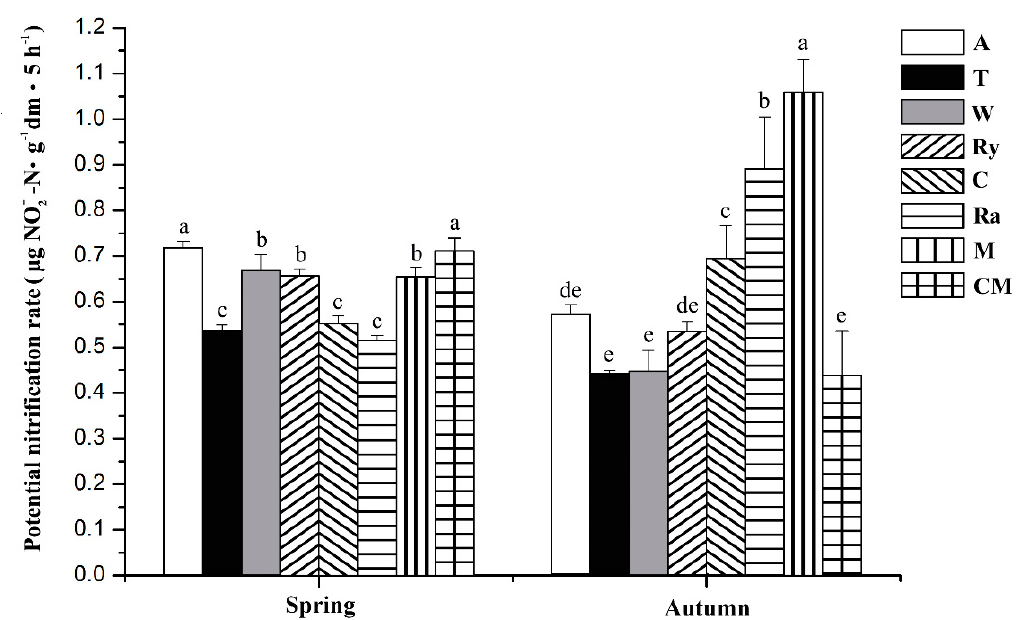
Figure 2. Effects of different intercropping systems on the potential nitrification rate of cucumber in spring and autumn. A—alfalfa; T—trifolium; W—wheat; Ry—rye; C—chrysanthemum; Ra—rape; M—mustard; CM—cucumber monoculture. Columns with different letters are significantly different at 0.05 probability level.